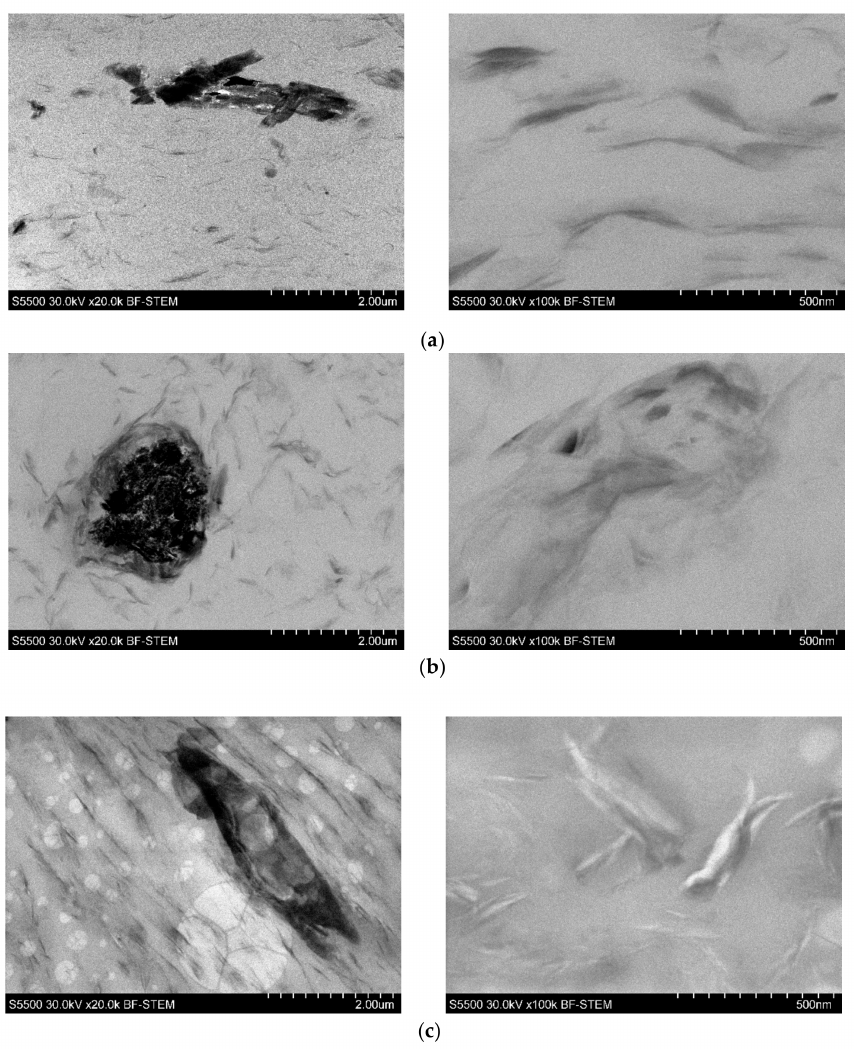
Figure 3. TEM images of 4n6H ( a ), 4n6LHP ( b ), and 4n3LHP3ZB ( c